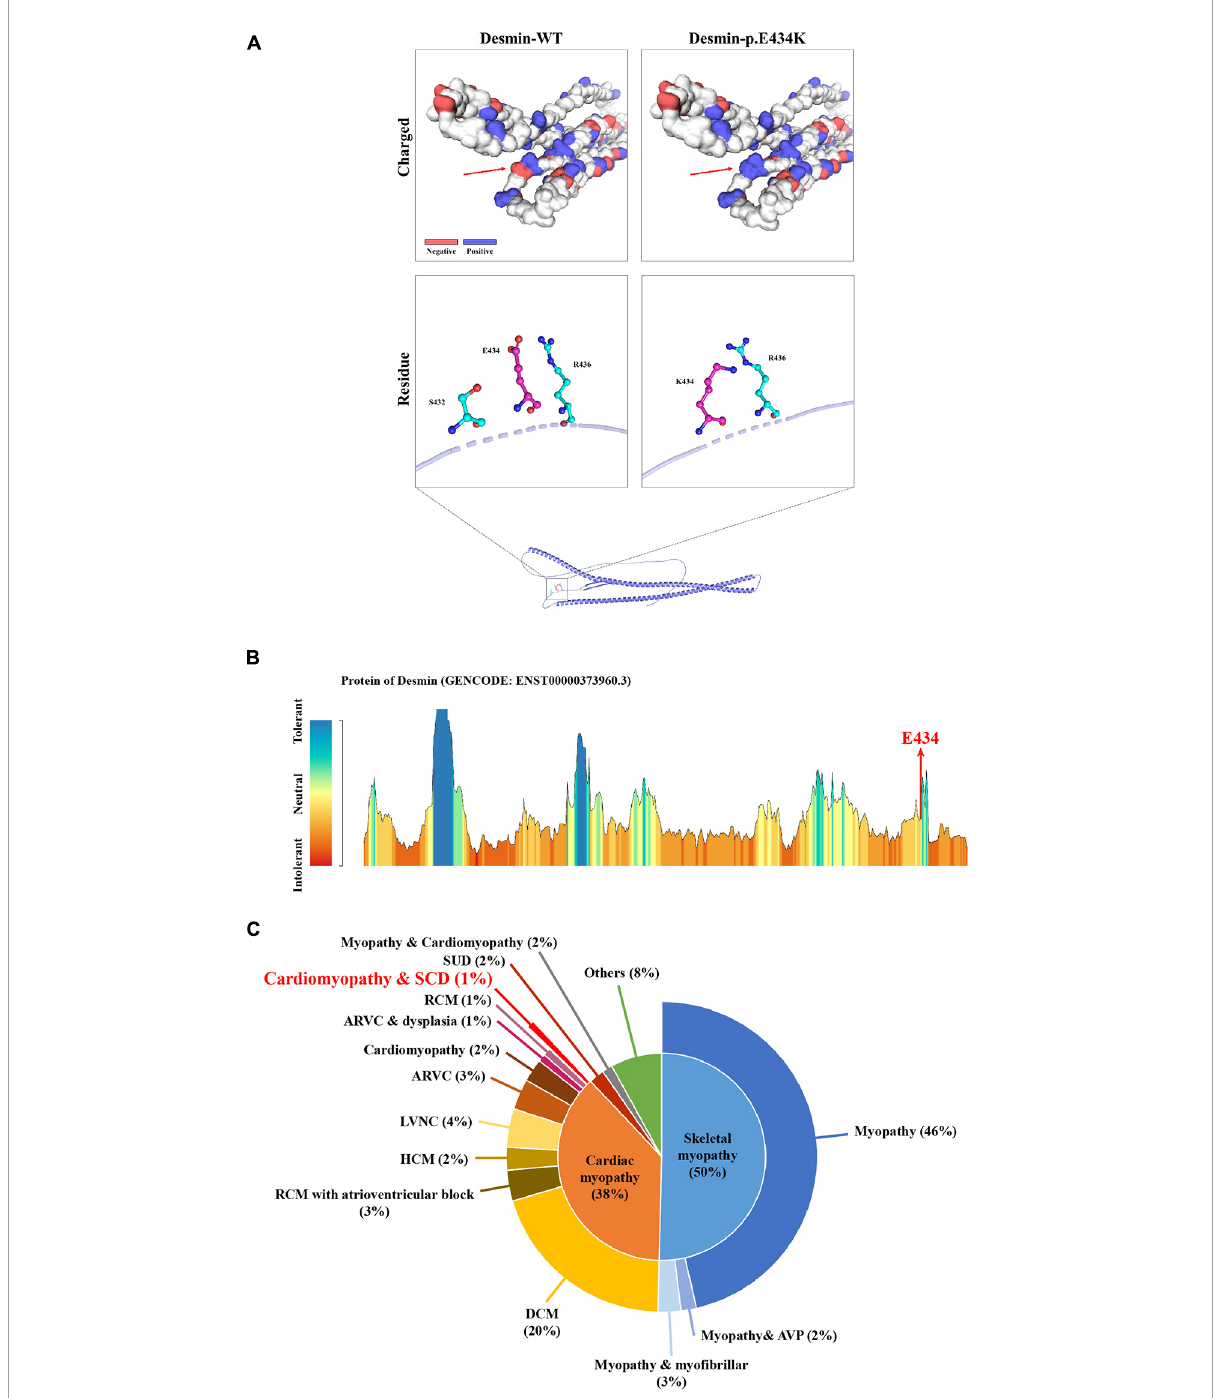
FIGURE2 The bioinformatics analysis of mutations. Structure prediction of the mutant protein. The wild-type DES (DES-WT) protein structure and the p. E434K mutant DES (DES-p. E434K) protein structure were predicted by SWISS-MODEL online software. (A) Red arrow shows the charged change of desmin protein. In the DES-WT protein, E434 is hydrophobic with S432 and R436. In the DES-p.E434K protein, the hydrophobic effect with S432 disappeared after E434K mutation, while the hydrophobic effect with R436 remained (B) MetaDome server was used to identify the intolerant regions in DES. As depicted, the affected nucleotide/residue is located in an intolerant region. (C) Overview of all reported phenotypes caused by DES mutations. ARVC, arrhythmogenic right ventricular cardiomyopathy; AVP, autophagic vacuolar pathology; DCM, dilated cardiomyopathy; HCM, hypertrophic cardiomyopathy; LVNC, left ventricular non-compaction; RCM, restrictive cardiomyopathy; SCD, sudden cardiac death; SUD, sudden unexplained